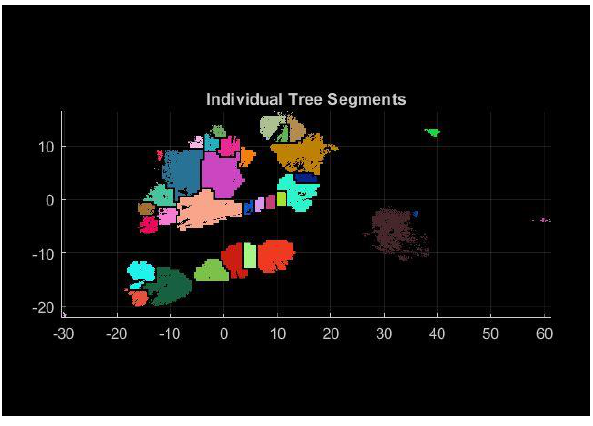
Figure 10. Individual tree segments obtained after segmentation.